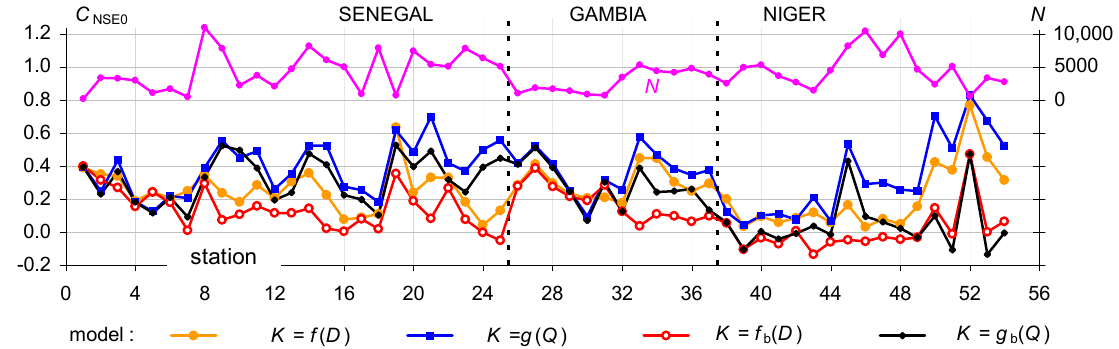
Figure 5. E ffi ciency coe ffi cient C NSE0 and number N of calibration of models 1 to 4 describing K as a Figure 5. Efficiency coefficient C NSE0 and number N of calibration of models 1 to 4 describing K as a function of D or Q , for each station function of D or Q , for each station analyzed.